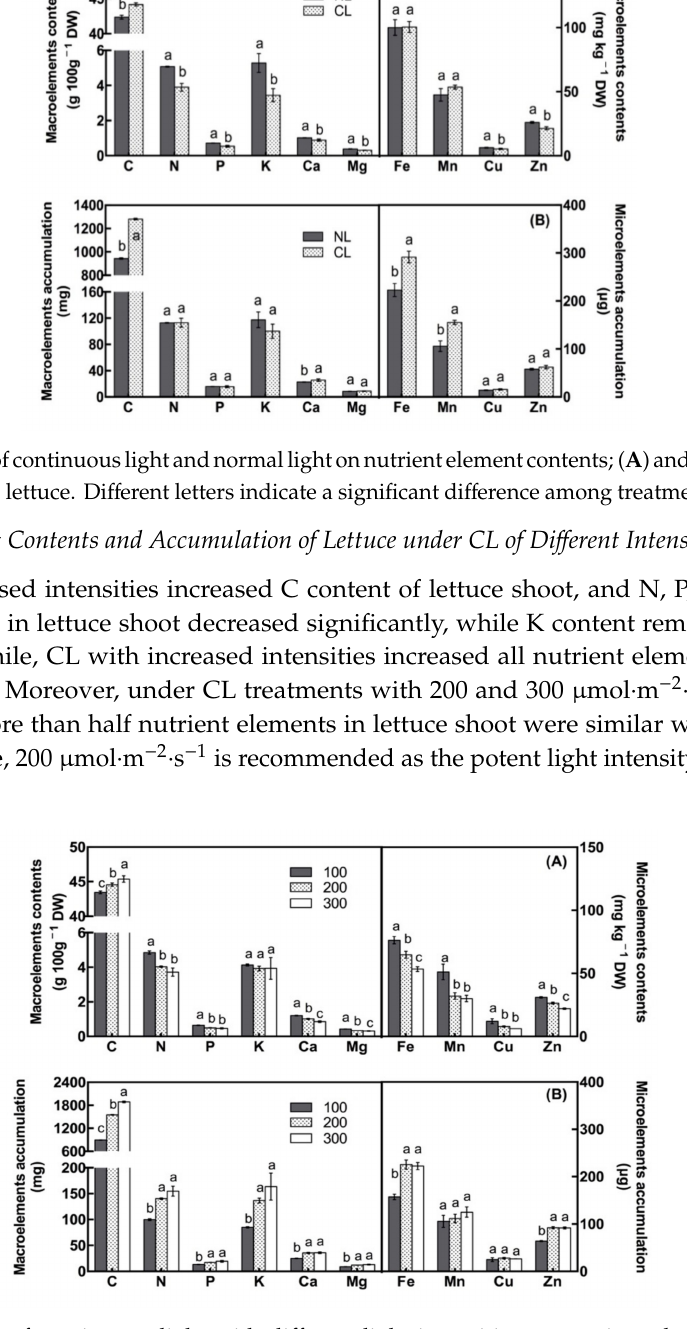
Figure 3. E ff ects of continuous light with di ff erent light intensities on nutrient element contents; ( A ) and accumulation; ( B ) of hydroponic lettuce. Di ff erent letters indicate a significant di ff erence among treatments at p <